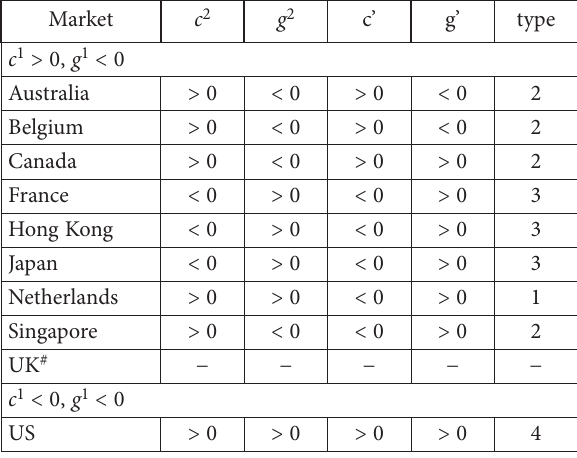
Table 4. The type of asymmetric patterns of two volatilities for 10 REIT